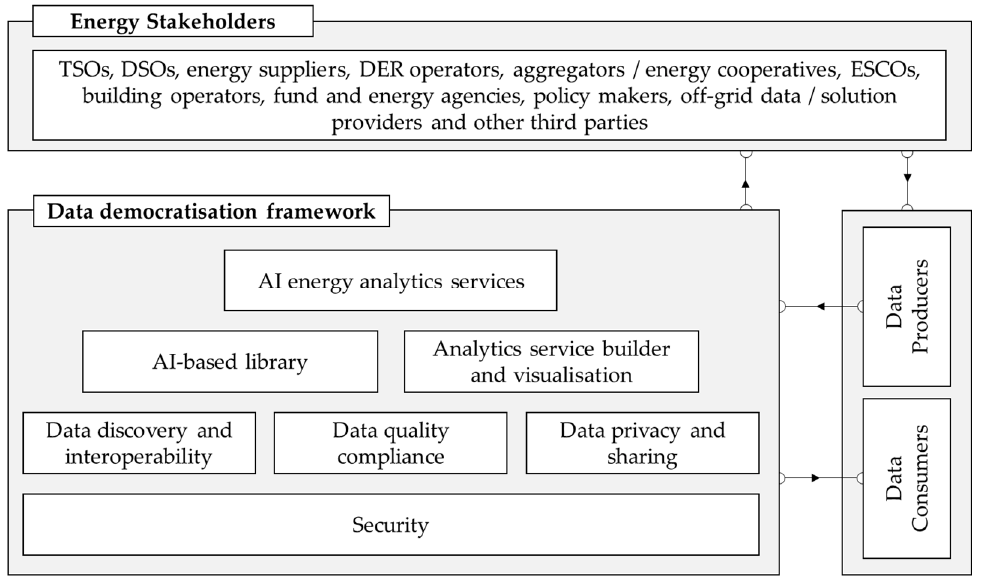
Figure 1. Data democratisation framework for intelligent energy management.